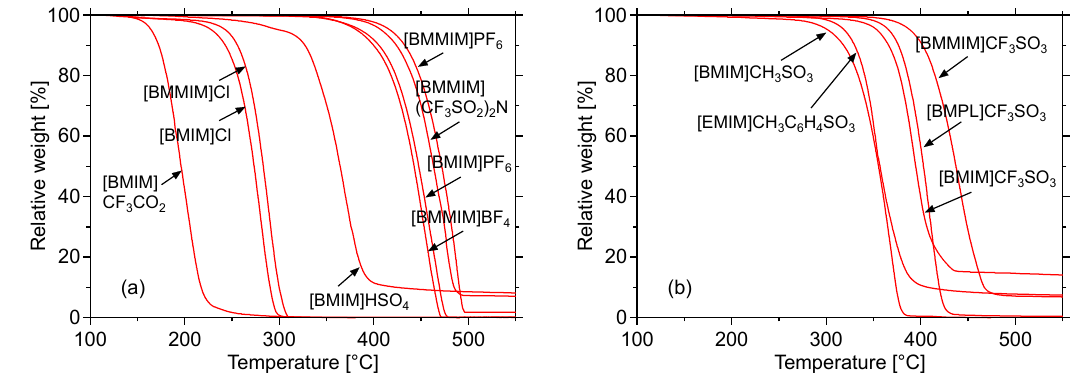
Figure 2. Weight loss curves of ILs; TGA under flowing nitrogen with 5 °C/min heating rate.